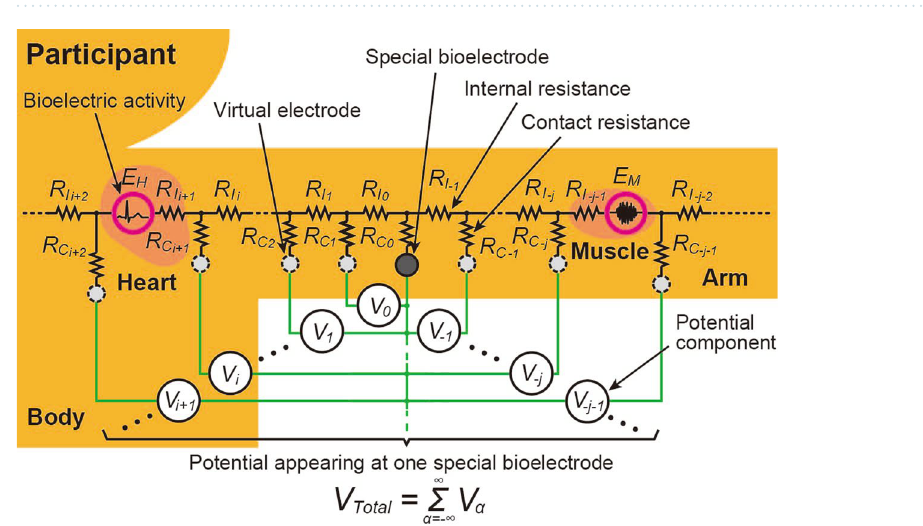
Figure 5. ( a ) Examples of bioelectric signals in rest state (participant A) and ( b ) peak value of R-wave of ECG obtained at each measurement point. Measurement accuracies of the waveforms at thorax (V3), biceps brachii (BB), flexor carpi (FC), and extensor carpi (EC) were 5.3, 2.6, 2.6, and 2.6 µV, respectively.